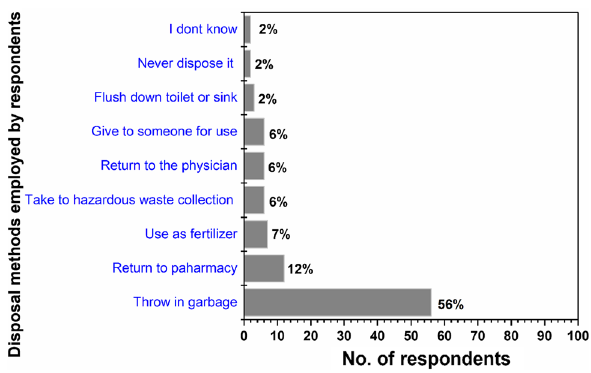
Fig. 5 Different disposal methods employed by respondents ( n =